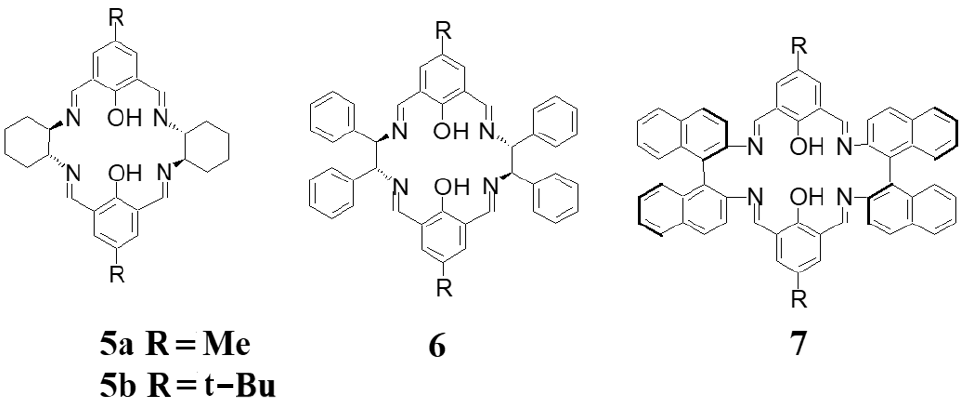
Figure 3. Formation of a mixture of [2 + 2] and [3 + 3] products.